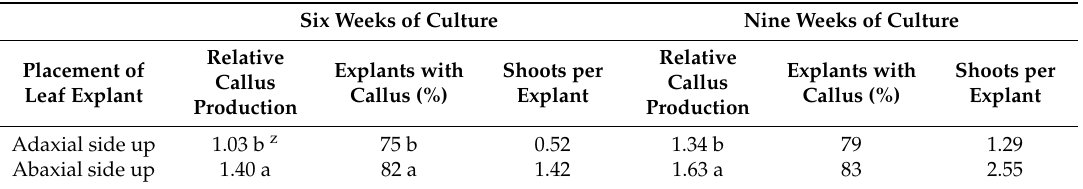
Table 4. E ff ect of leaf placement—adaxial or abaxial side up—on relative callus formation, % explants with callus, and shoots per explant from leaf explants of Fragaria vesca cv. Baron Solemacher. Six Weeks of Culture Nine Weeks of Culture